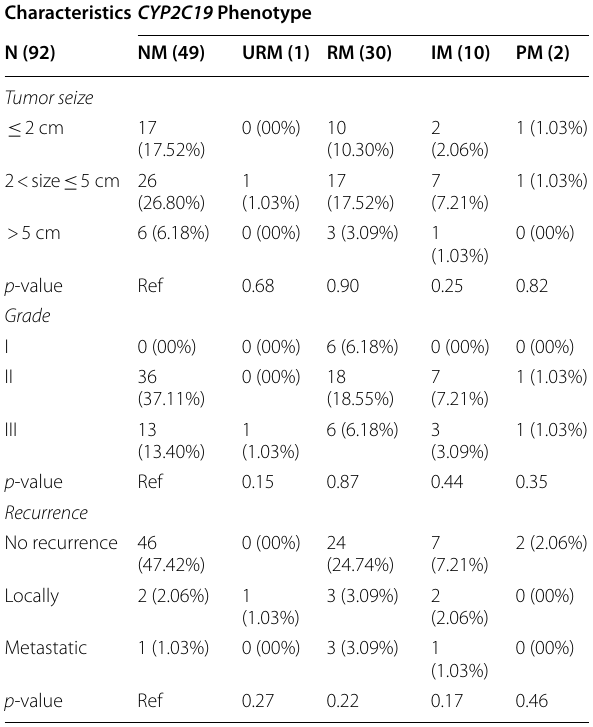
Table 4 Clinical characteristics of patients in association with CYP2C19